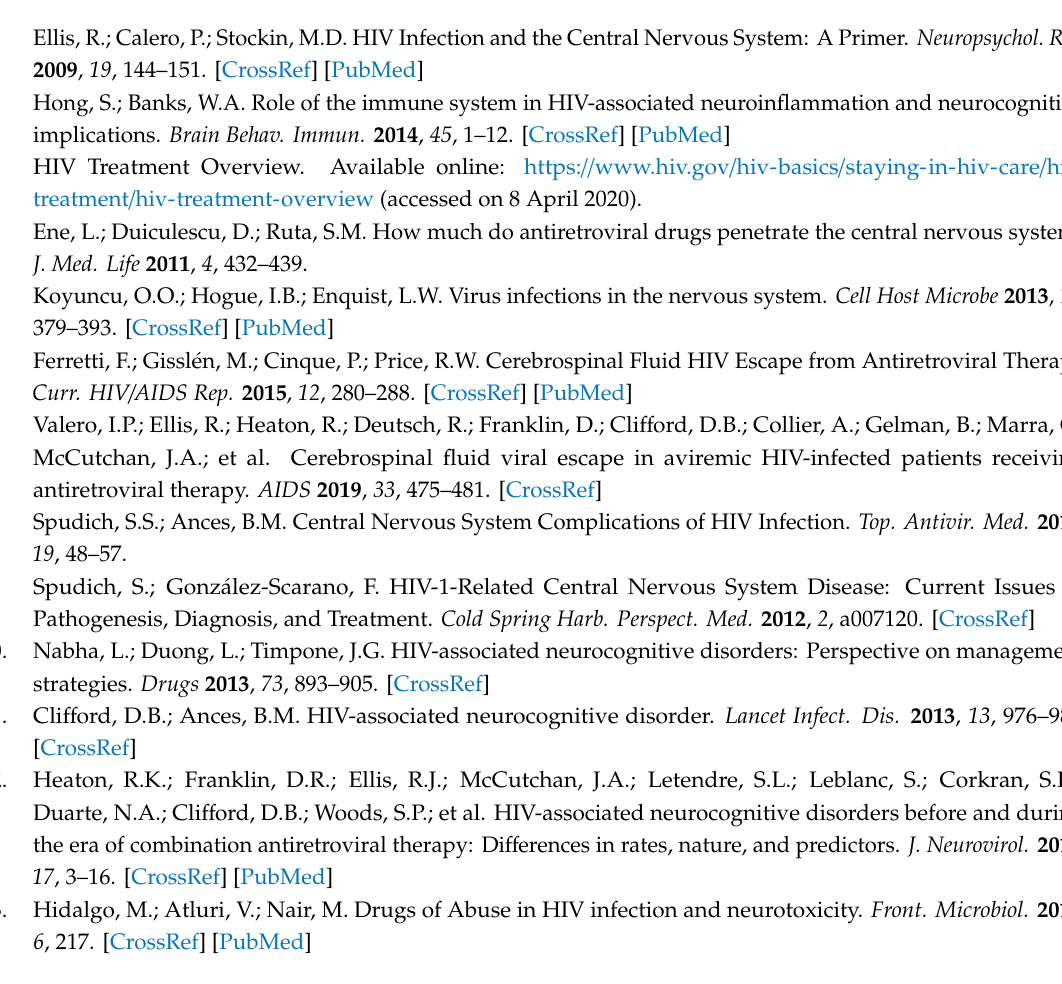
Figure S1: Original Western blots of expression of neuronal and astrocyte marker proteins in plasma EV of Healthy and HIV-positive subjects, Figure S2: Original Western blots of expression of GFAP and L1CAM in plasma EVs of healthy and substance users, Figure S3: Original Western blots of expression of neuronal and astrocyte proteins in plasma EVs of HIV-positive subjects with and without substance